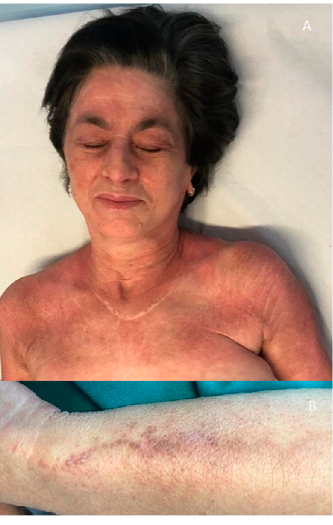
Figure 1. ( A ) Palpebral edema; heliotropic erythema of face, neck, chest, shoulder and arms. ( B ) Particular of hyperkeratotic, erythematous, follicular confluent papules arranged in a linear fashion on forearm.